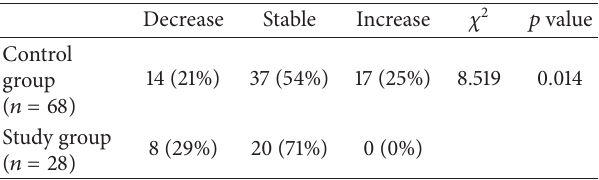
Table 4: The effects of CIT on distribution of virus load in HCC.